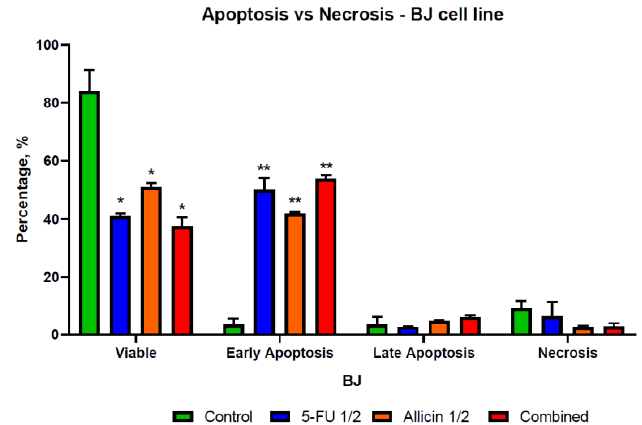
Figure 7. The illustration of apoptosis and necrosis in the BJ cell population. BJ cell line ratio between viable, apoptotic, and necrotic cells, with an increased number of early apoptotic cells, for all treatments.